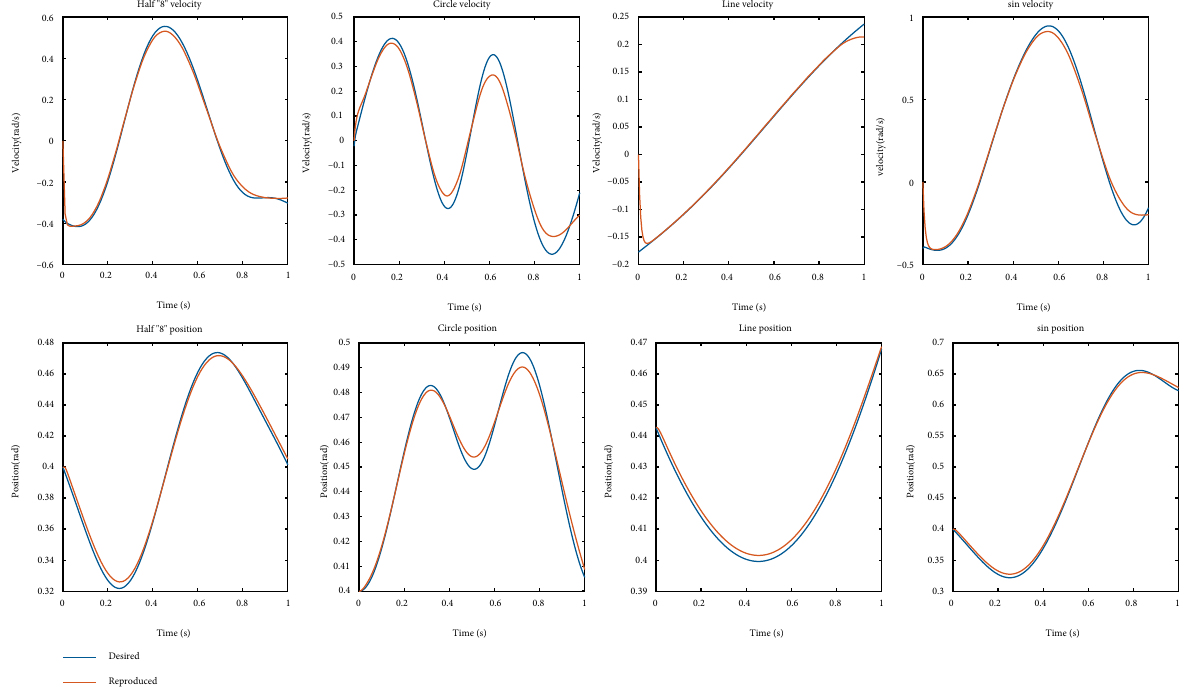
Figure 13: The experimental data of joint